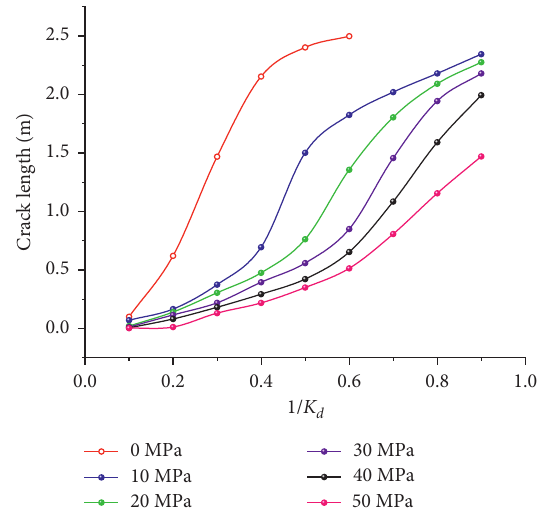
Figure 17: Crack lengths with different decoupling coefficients and different in situ stresses.